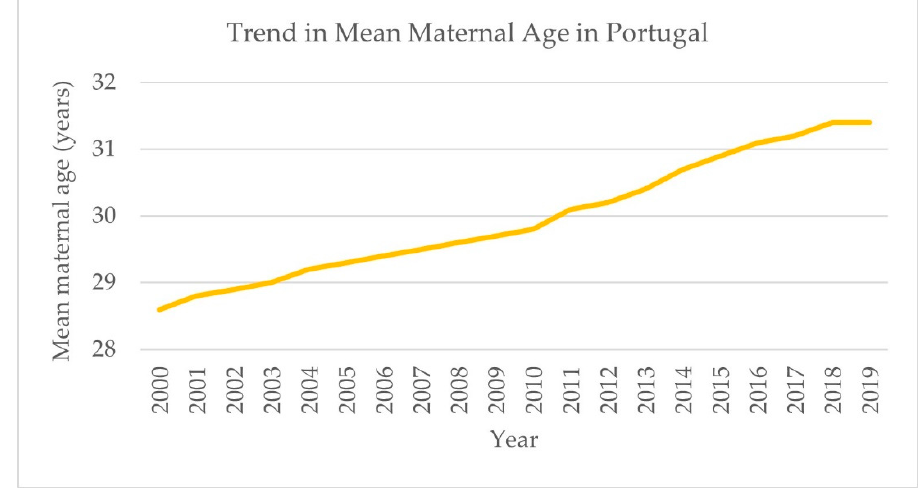
Figure 6. Graph showing trend in mean maternal age at birth of a child in Portugal between 2000 and 2019. Source: based on data retrieved from the National Institute of Statistics portal [26].